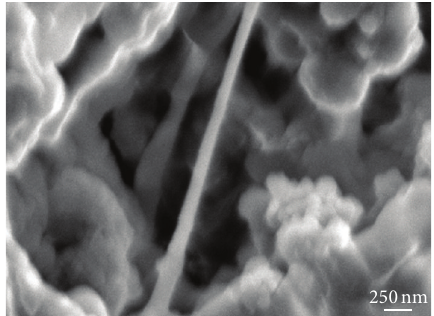
Figure 6: SEM image of the fracture surface of PLC-5BNNT composite showing polymer coated BNNTs of varying diameters